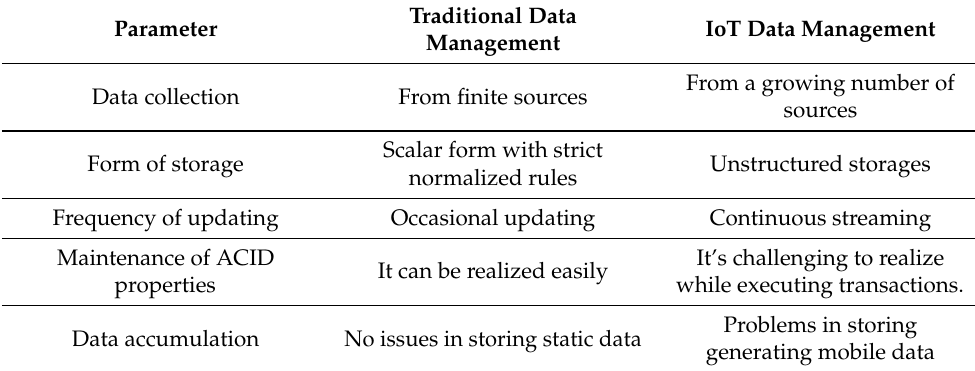
Table 5. Advantages and disadvantages of emerging IoT connectivity